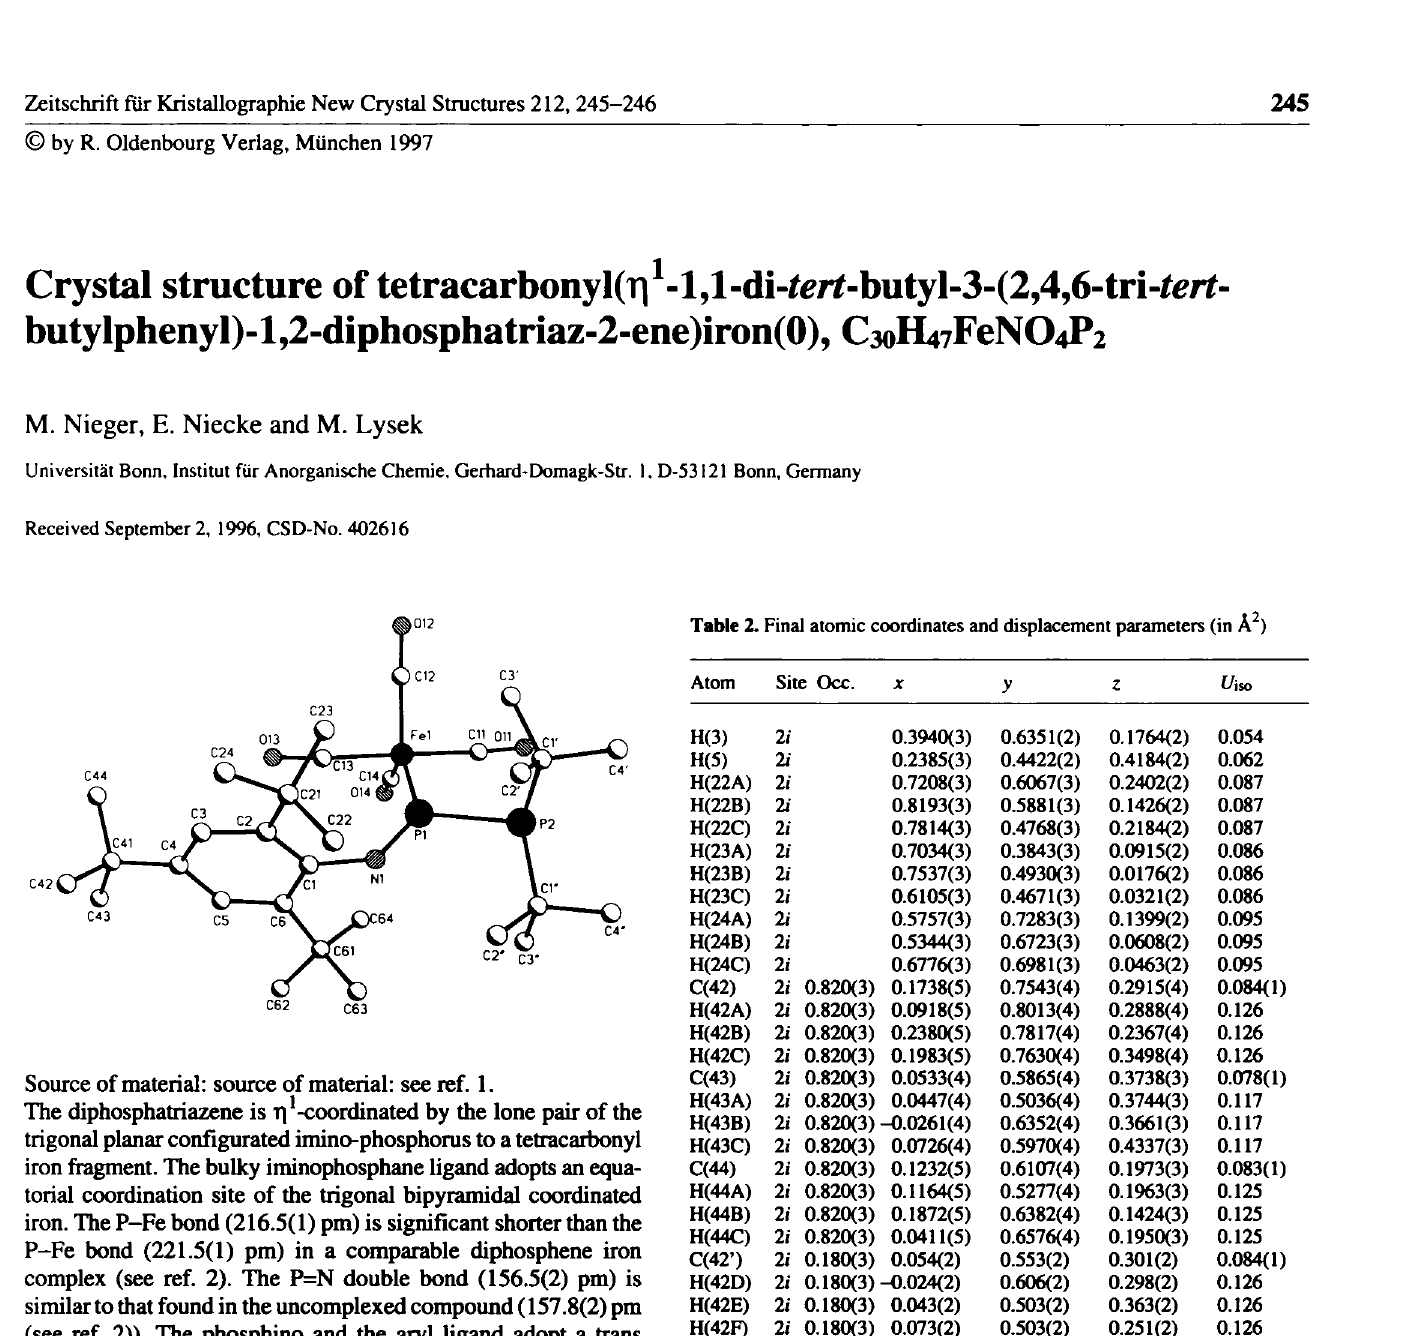
Table 1. Parameters used for the X-ray data collection